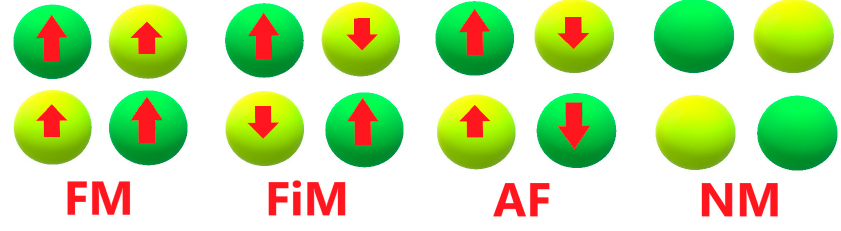
Figure 2. The schematic diagram of four magnetic states: FM, FiM, AF and NM.